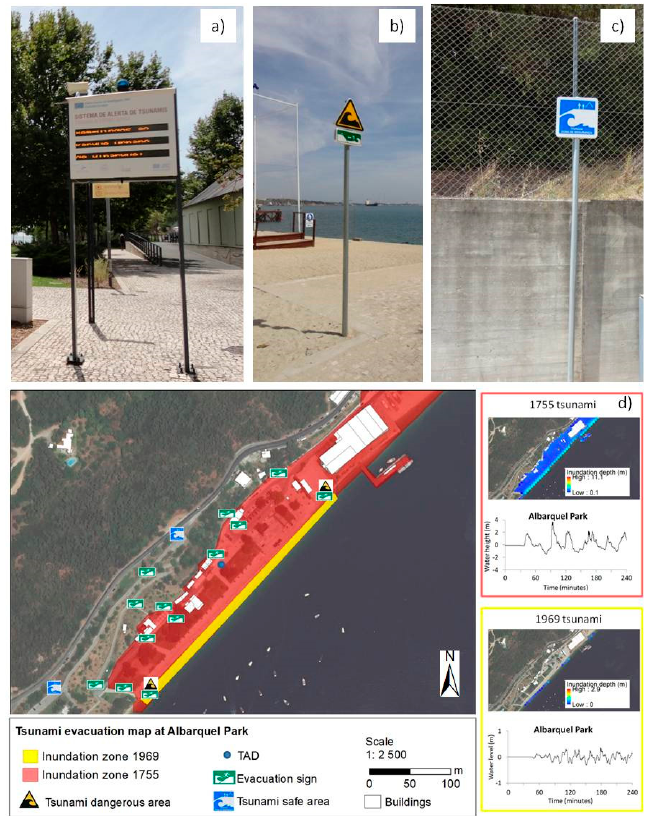
Figure 6. Installed equipment at the Albarquel Urban Park (AUP, see location in Figure 1) and evacuation map: ( a ) Tsunami Alerting Device (TAD); ( b ) signs of tsunami dangerous area and evacuation; ( c ) sign of tsunami safe area; ( d ) tsunami evacuation map at AUP (adapted from [13]).